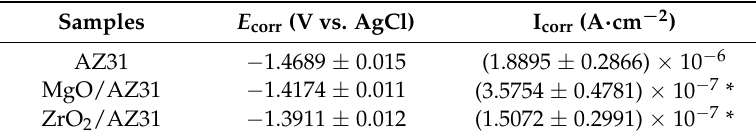
Table 2. Relative electrochemical parameters (Mean ± SD).